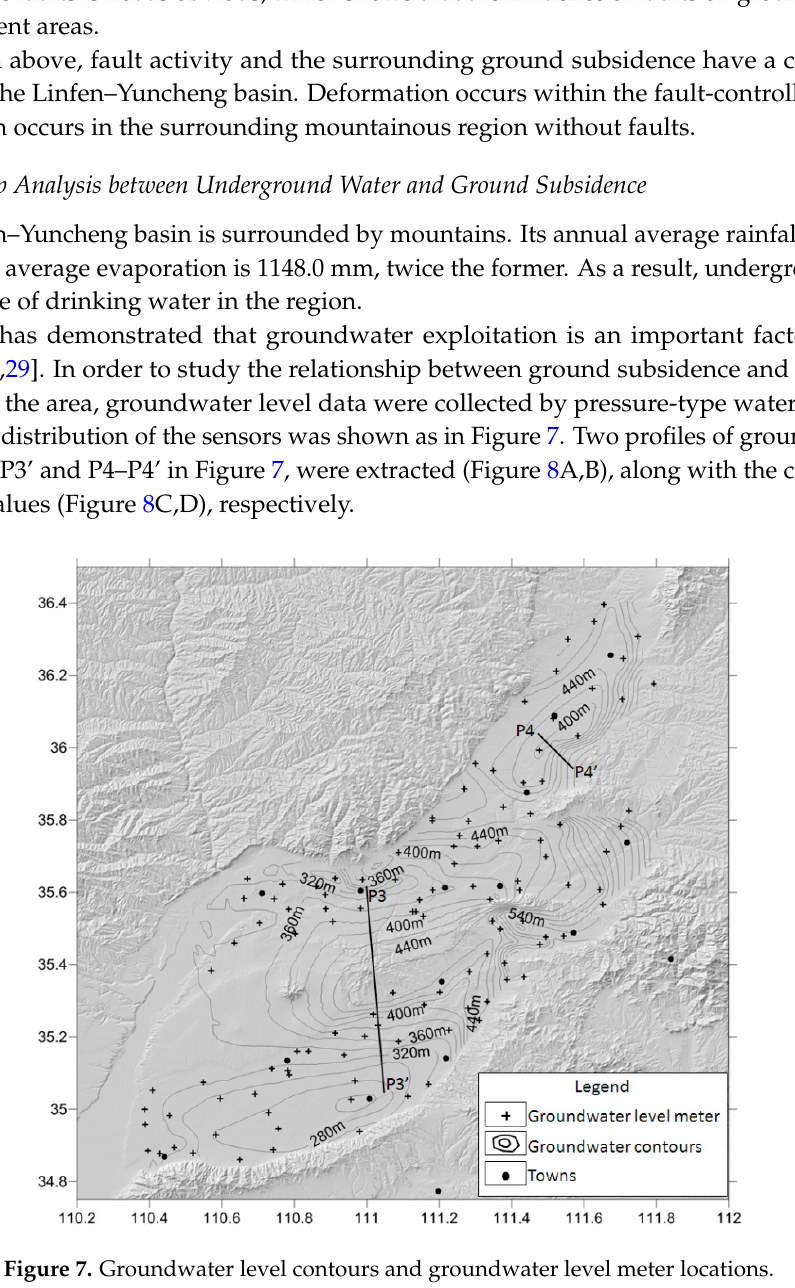
Figure 7. Groundwater level contours and groundwater level meter locations.